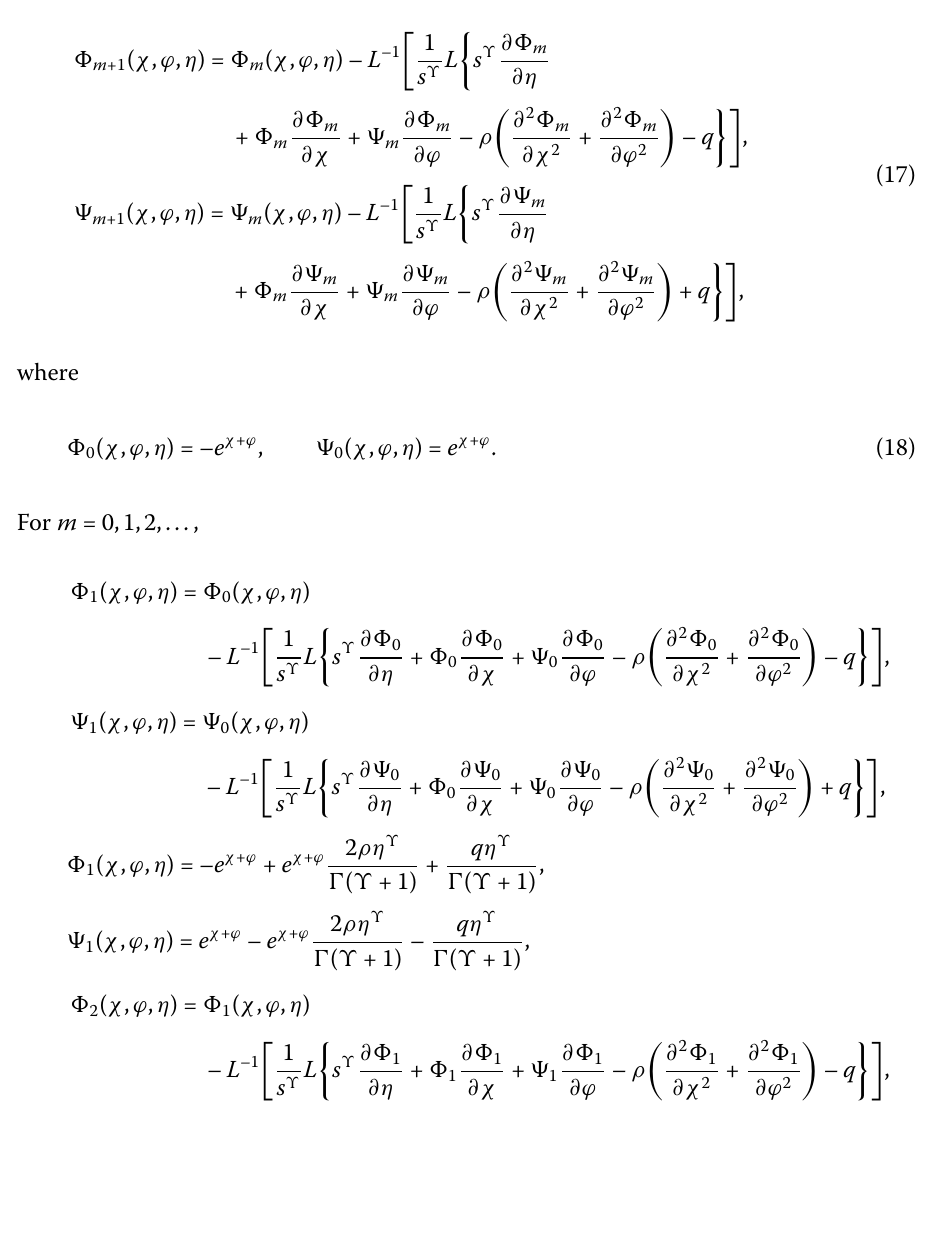
Using the iterative method according to equation (7) in equation (15), we